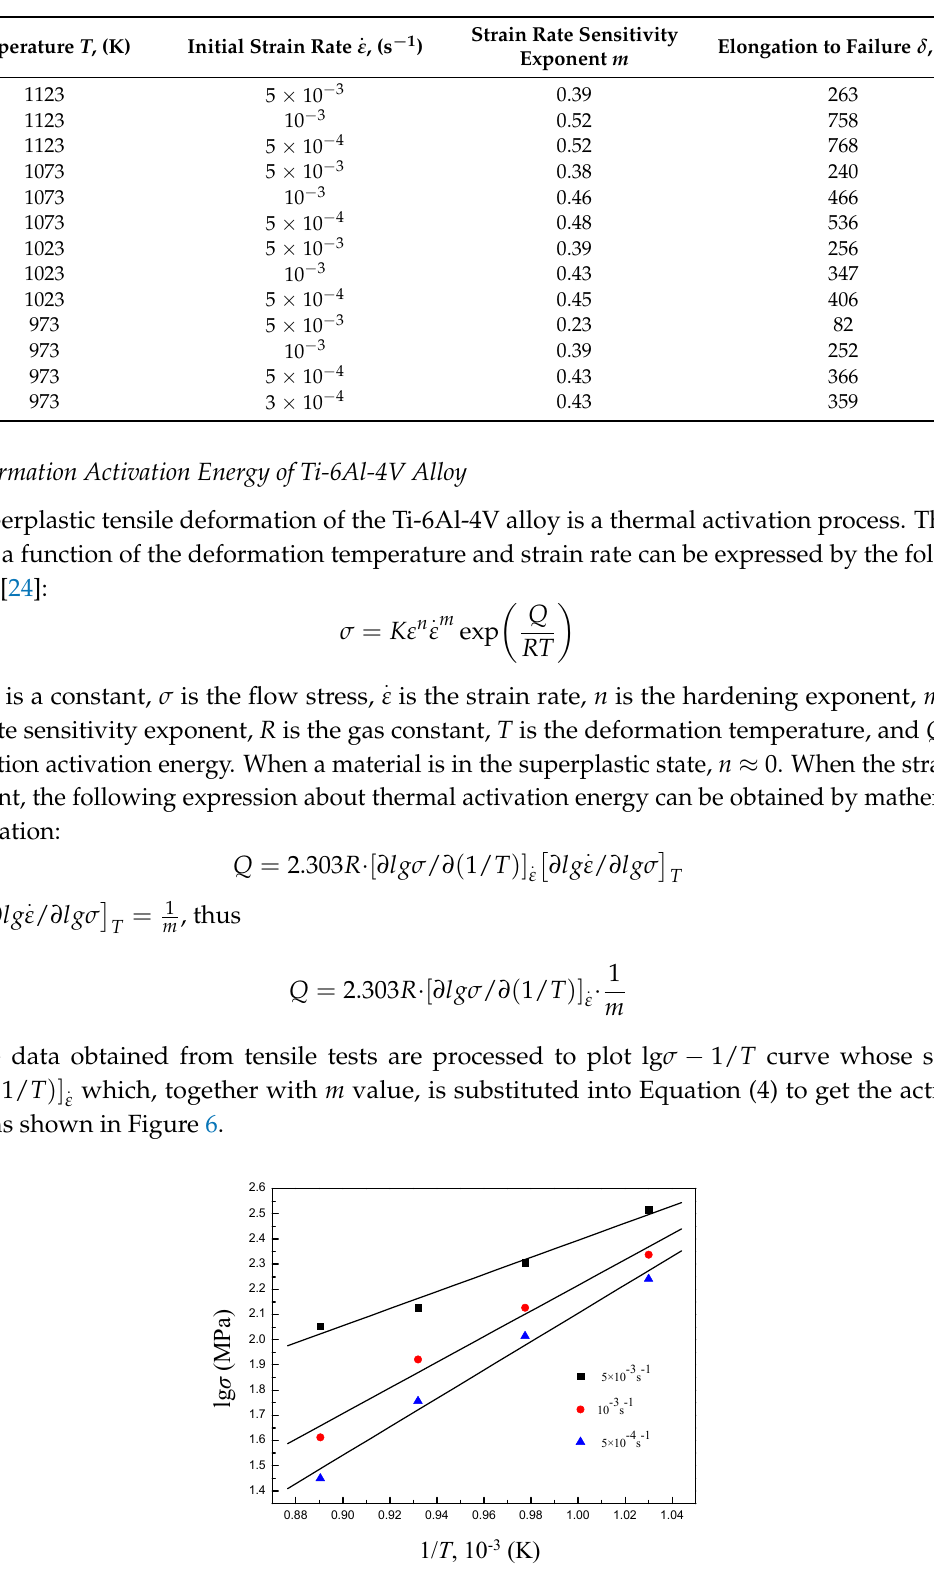
Table 1. Measured δ and calculated m values as a function of deformation temperature and strain rate in Ti-6Al-4V alloy.